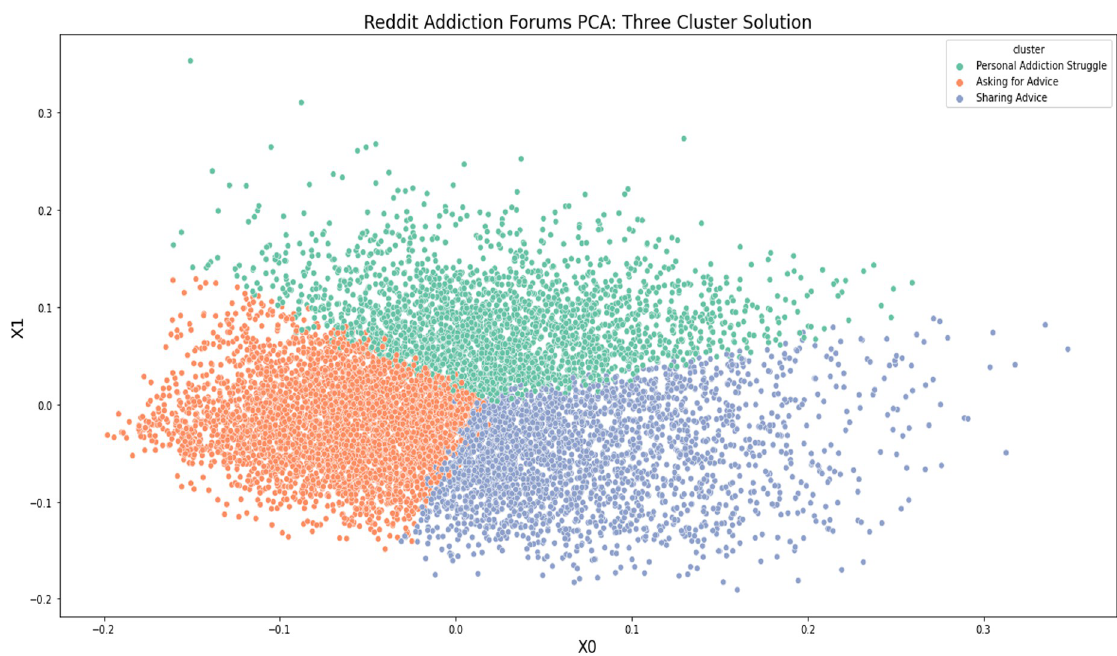
Fig 2. The following vector map reflects a k-means clustering and principal components analysis (PCA) for 9,066 Reddit posts collected from addiction and recovery subreddits.